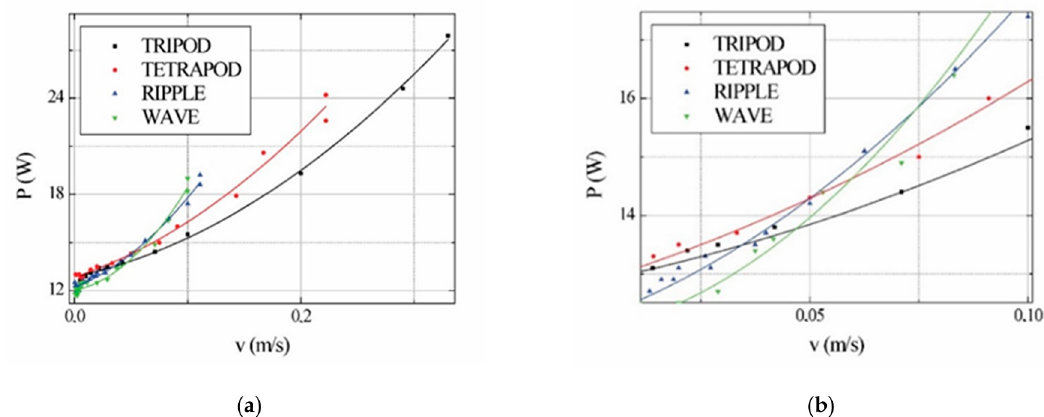
Figure 3. Average power dependence on robot speed and gaits: ( a ) normal view, ( b ) enlarged view. Experiments were carried out without additional load on the robot. Each dot represents a separate experiment with a certain configuration. Lines show polynomial approximation. No gait type switching was